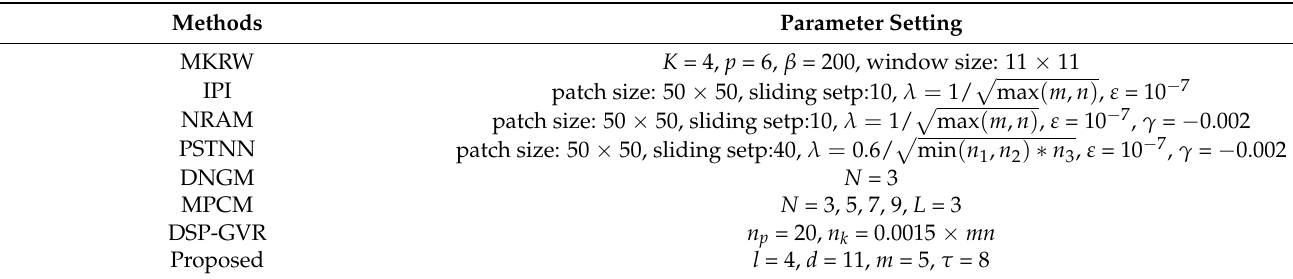
Table 2. Parameter setting of eight